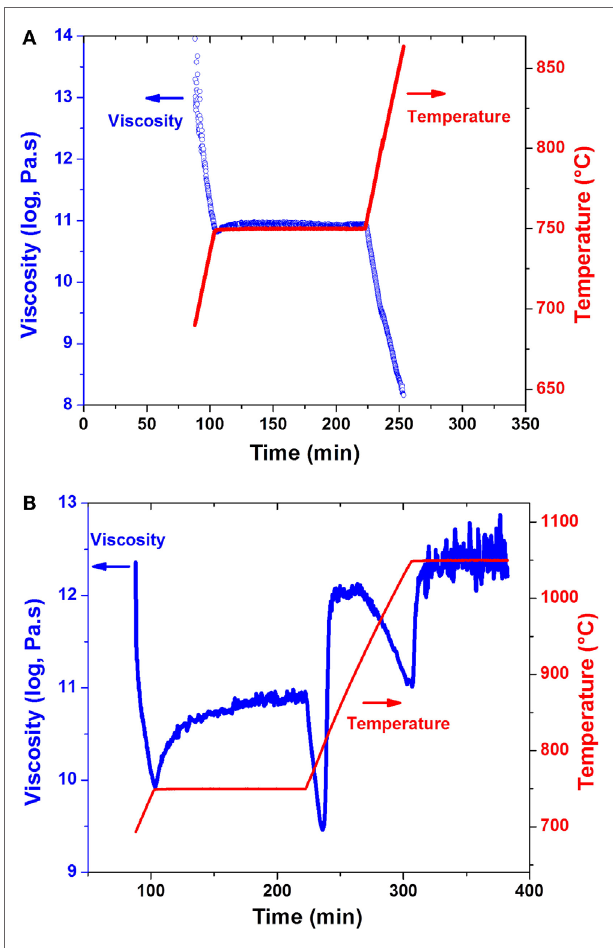
FigUre 6 | Viscosity–time–temperature plots of glass compositions (a) #1 and (B) #5 as a function of heat treatment